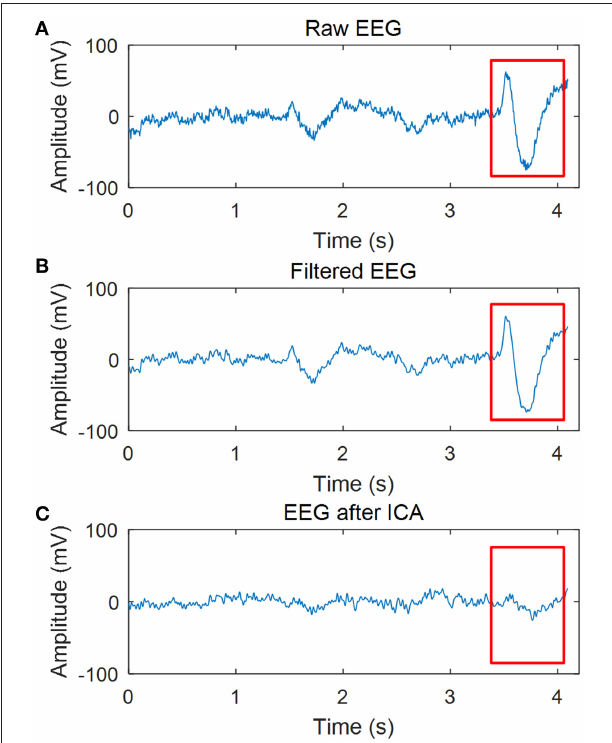
FIGURE 2 | Effect of data processing. (A) Raw EEG. (B) EEG after 0.5 ∼ 45Hz filtering. (C) EEG after filtering and